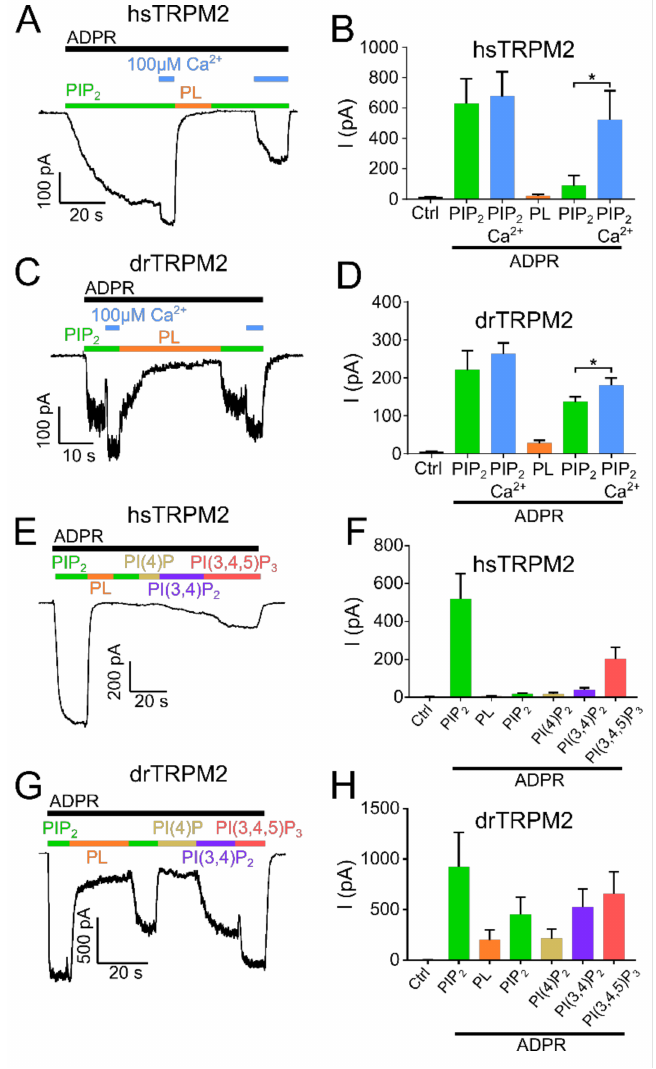
Figure 2. Influence of high calcium and PIP 2 derivatives on TRPM2 current restoration. Recordings of HEK-293 cells expressing TRPM2 at − 60 mV in the inside-out patch clamp configuration. Currents were activated by cytosolic exposure to ADPR (black bar) and PIP 2 (25 µ M) (green bar). Representa- tive current trace and statistics of hsTRPM2 ( A , B ) and drTRPM2 ( C , D ) at high Ca 2+ concentrations (100 µ M). High Ca 2+ in presence of PIP 2 and ADPR (blue bar) causes current restoration after the current was inhibited via 15 µ g/mL polylysine (PL, orange bar). Representative recordings and summary of current statistics of the effect of PI derivatives on hsTRPM2 ( E , F ) and drTRPM2 ( G , H ) currents using 1 µ M cytosolic Ca 2+ . Statistical analysis was performed via paired Student’s t -test and data presented as mean ± SEM; n = 4–7; * p <